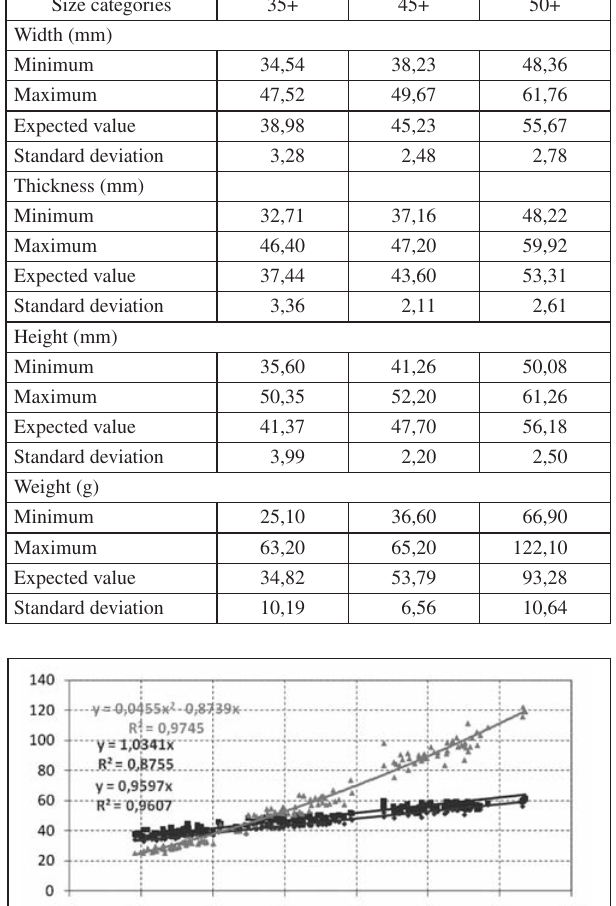
Fig. 28: Distribution of the width values of AA of Bergarouge